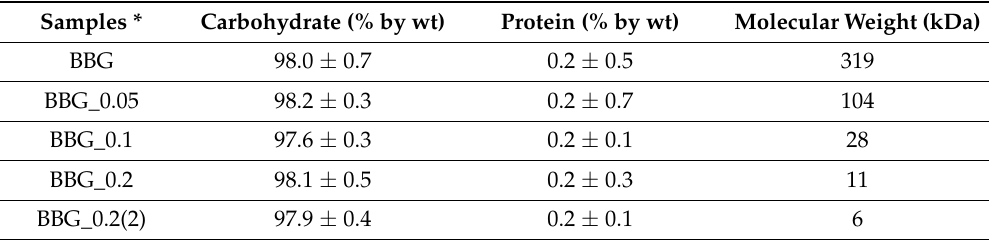
Preparation and structural characteristics of barley β -glucans (BBG) and its acid hydrolyzed